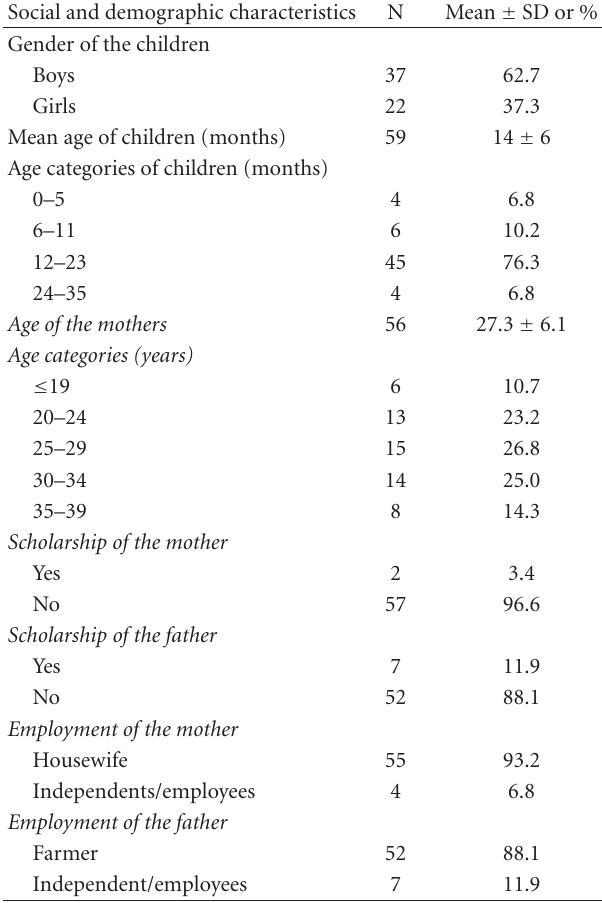
Table 1: Social and demographic characteristics of the household and the children admitted in two the nutritional rehabilitation centres in Burkina